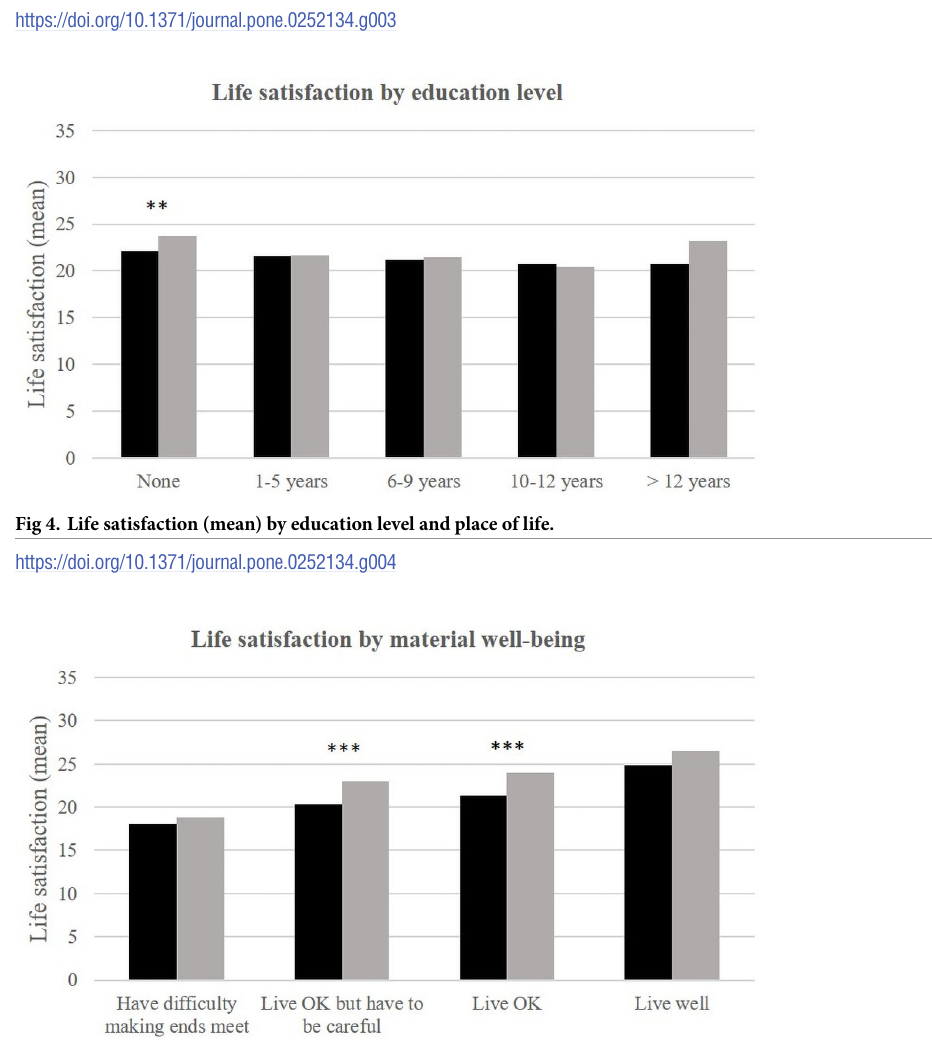
Fig 3. Life satisfaction (mean) by age and place of life.